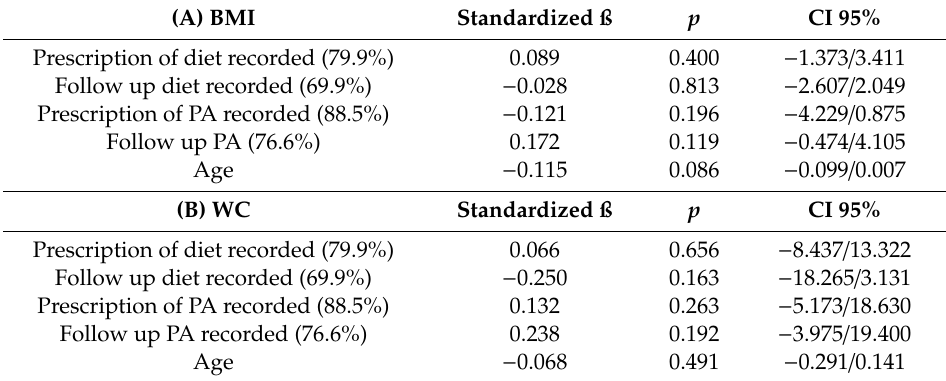
Table 4. Lineal regression model (women): ( A ) BMI (dependent variable); ( B ) WC (dependent